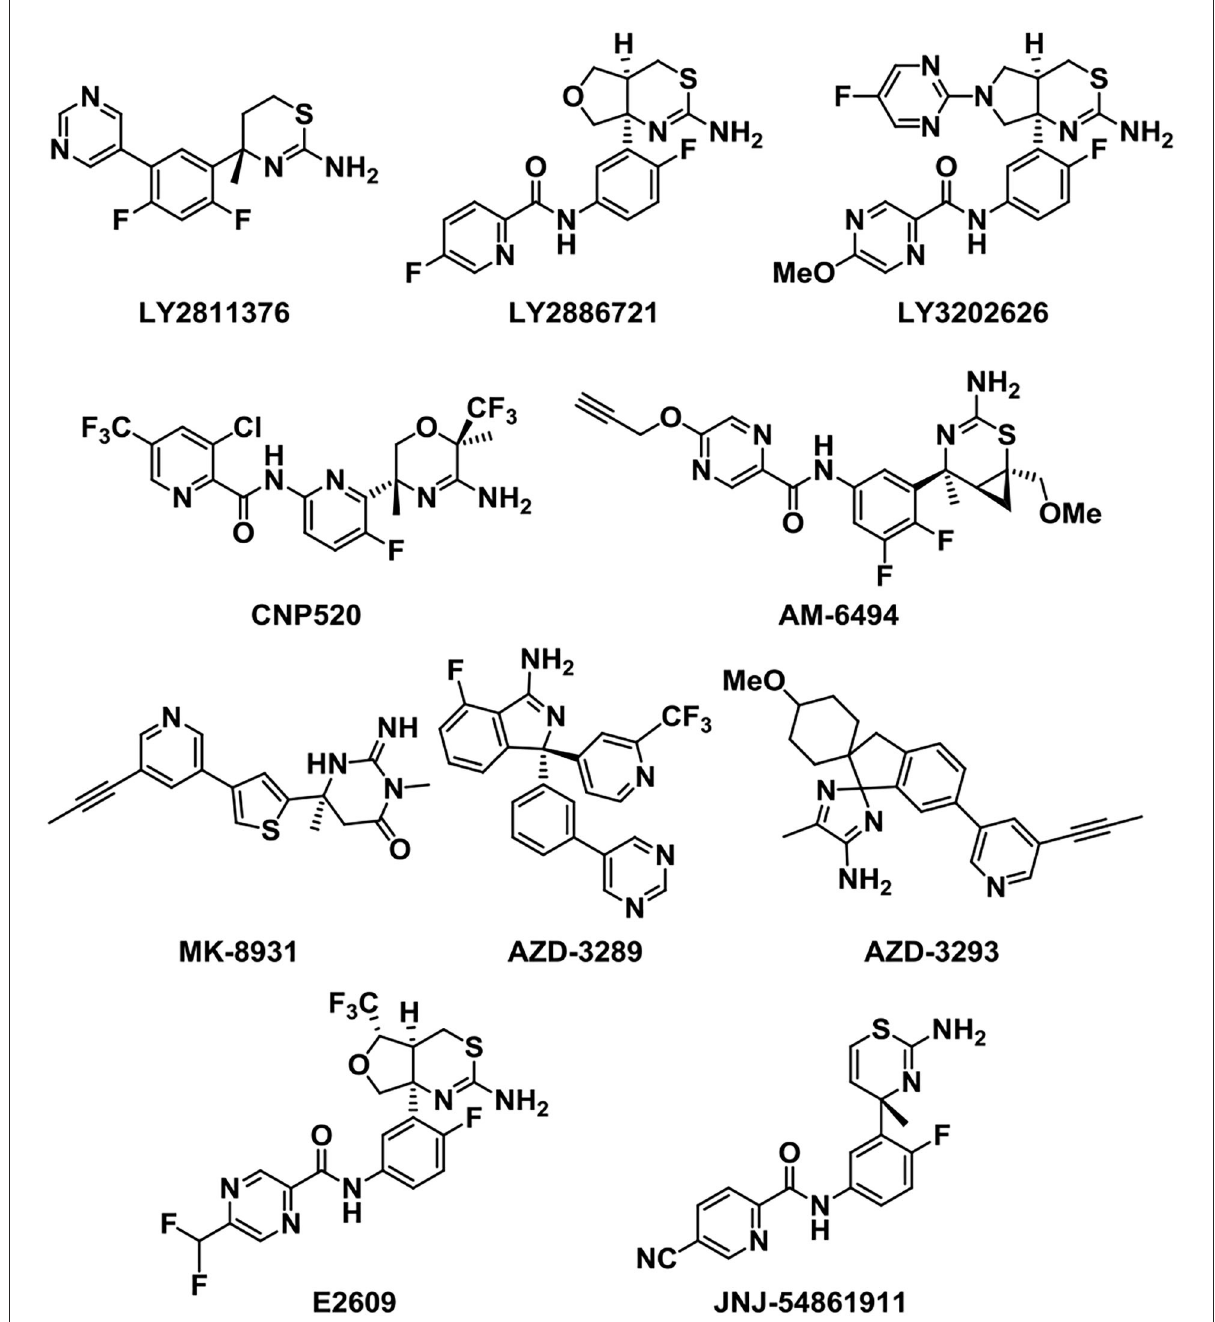
FIGURE6 Structures of the beta-site APP cleaving enzyme 1 (BACE1) inhibitors in study.